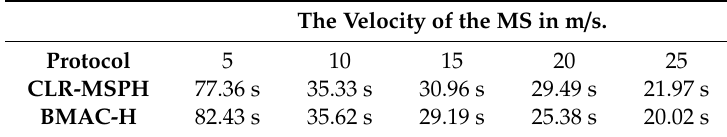
Table 4. The latency of packets received at the MS with varying the speed. The Velocity of the MS in m /